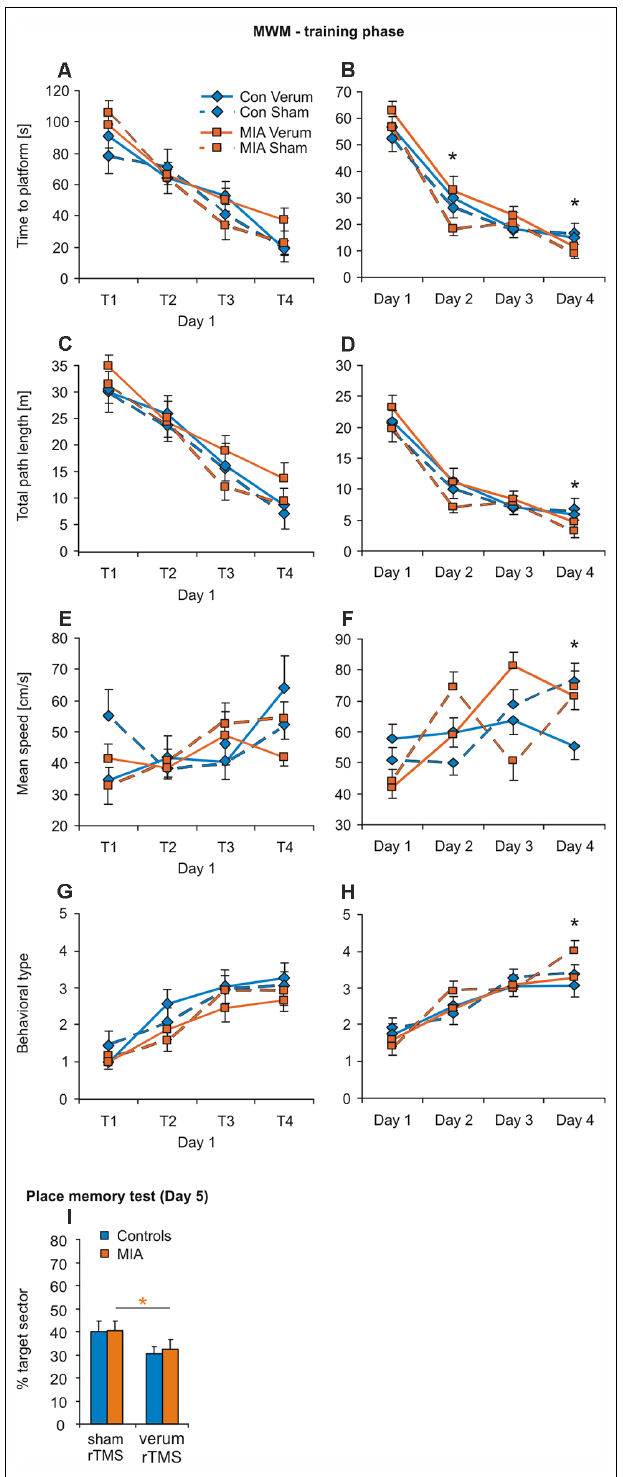
FIGURE 4 | iTBS applied to juvenile rats: effects on MWM. Training phase of MWM with the trials of day 1 (A,C,E,G) separately shown from the means of the trials for day 1–4 (B,D,F,H) for the measures: time to platform, total path length, mean swimming speed and behavioral type. (I) Results of the